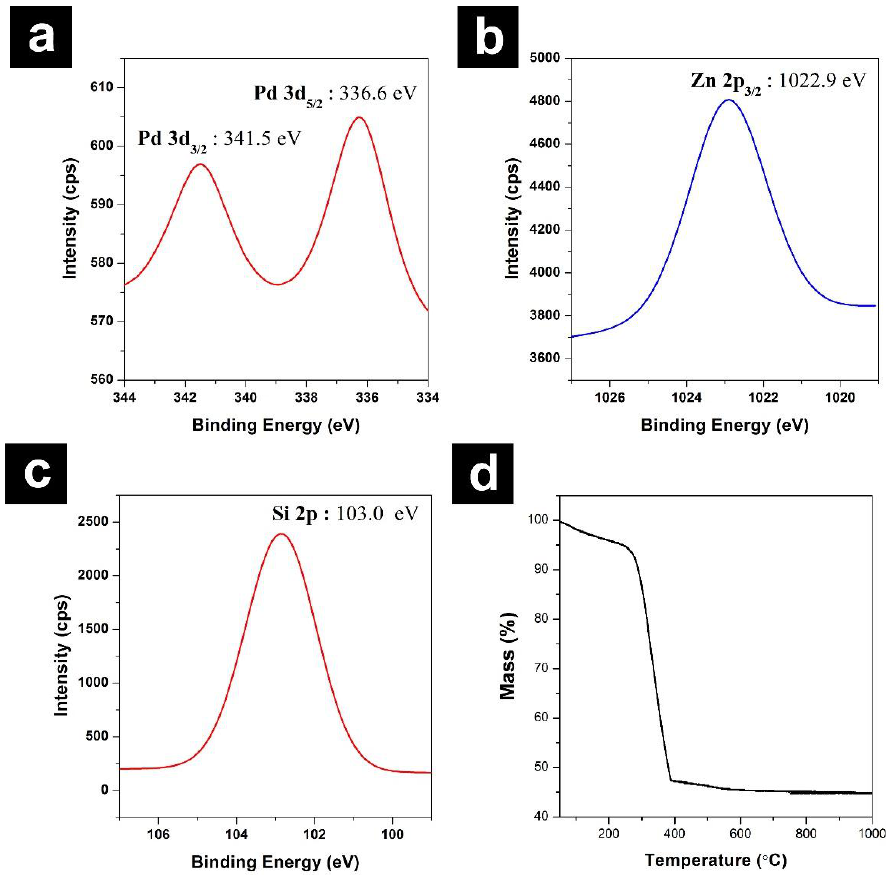
Figure 6. The XPS spectrums ( a – c ) of PdO/ZnO@mSiO 2 hybrid nanocatalyst and TGA curve ( d ) of PdO/ZnO@mSiO 2 hybrid nanocatalyst.